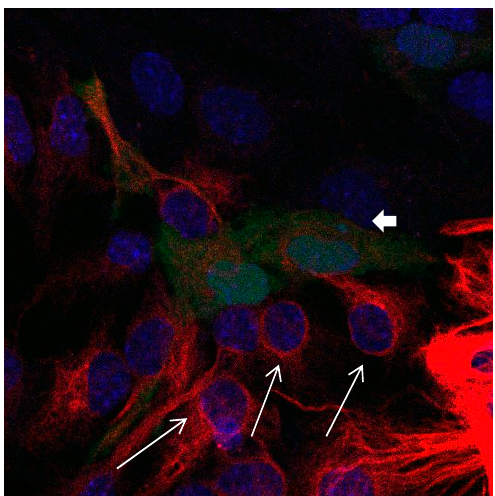
Figure 2. Cultures in a serum-containing medium, 5 days after passage: Immunofluorescence with anti-GFAP (glial fibrillary acidic protein) (red, secondary antibody: donkey anti-goat IgG Alexa Fluor 594), and with anti-Calbindin D28k (polyclonal antibody from the company SWANT) (green, secondary antibody: donkey anti-rabbit IgG Alexa Fluor 488); Nuclear staining with DAPI (4 ′ ,6-diamidino-2-phenylindole dihydrochloride) (blue). Confocal microscopy. Zoom = 4, numerous GFAP-positive and Calbindin D28k negative astrocytes (long arrows), in between 2 Calbindin D28k positive and GFAP-positive astrocytes (short arrows).